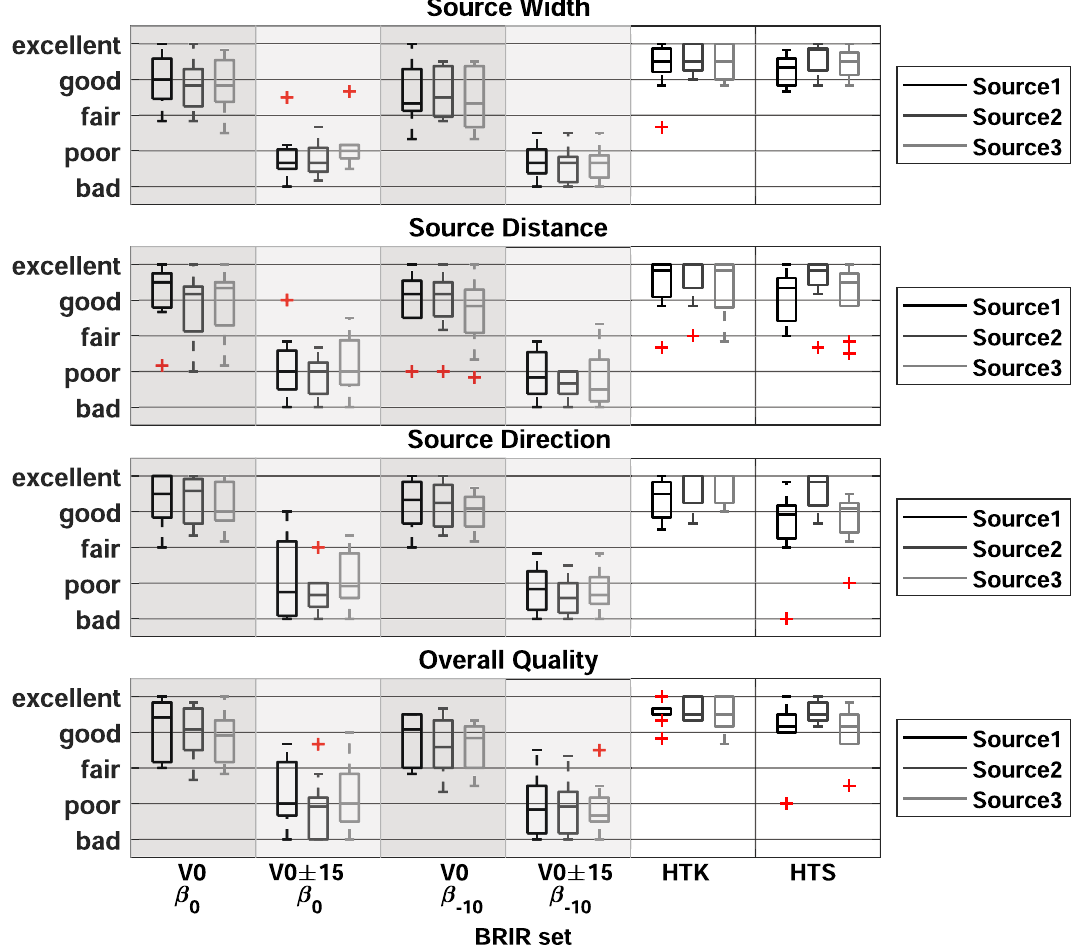
Figure 9. (Experiment 2) Perceptual ratings averaged over three repetitions, for four perceptual attributes, three source positions and six different BRIR